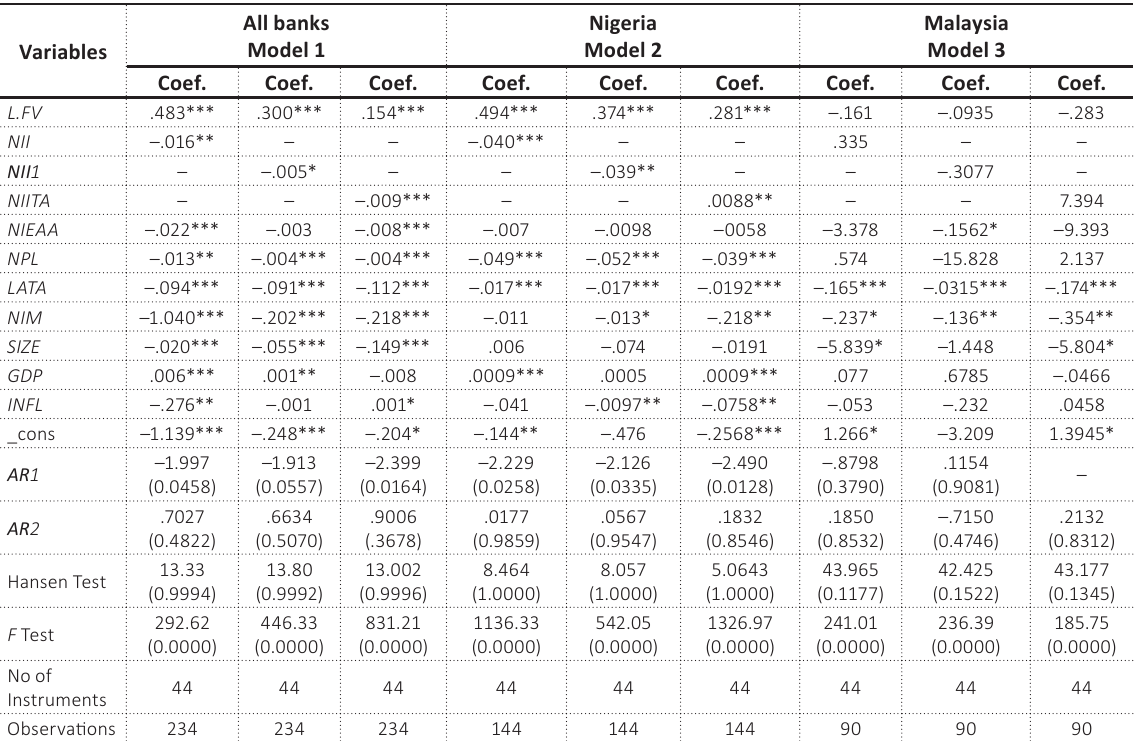
Table 2. Firm value sys-GMM model